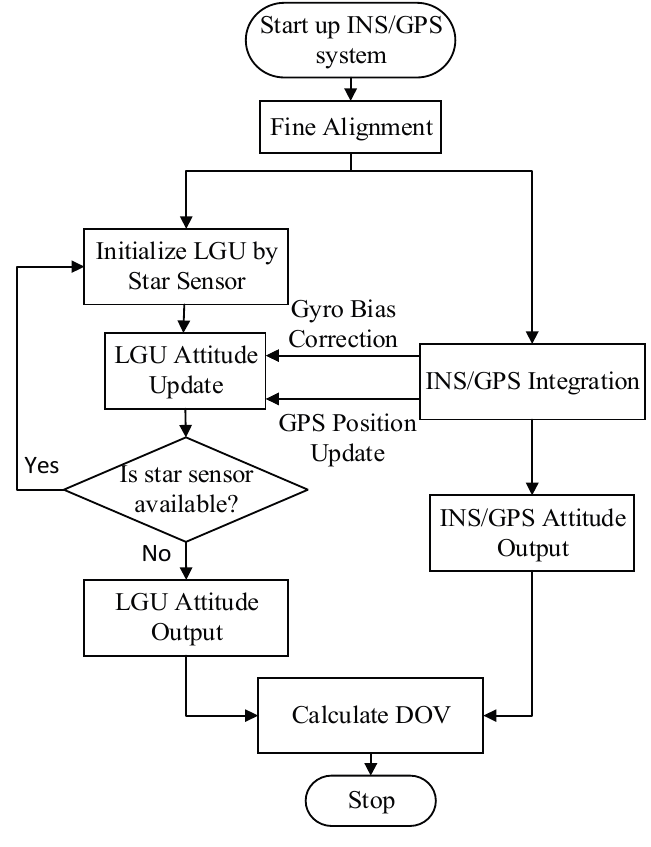
Figure 4. The procedure for DOV measurement. LGU, laser gyroscope unit.